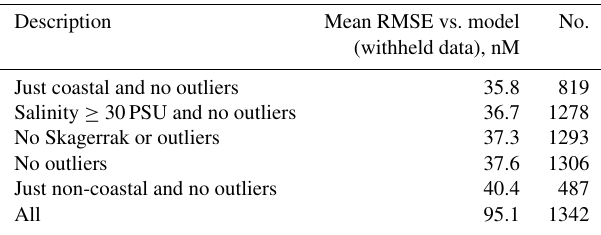
Table 2. Splits of dataset used to evaluate outliers and their per- formance against the withheld data. The root mean square error (RMSE) statistic given as the mean of the performance against the withheld data for 20 different models built from 20 different pseudo-random initialisations (Sect. 3.2). The model used here in- cludes ancillary variables of temperature, depth, and salinity which were thought to intuitively give a reasonable result. “No.” gives the number of samples in each